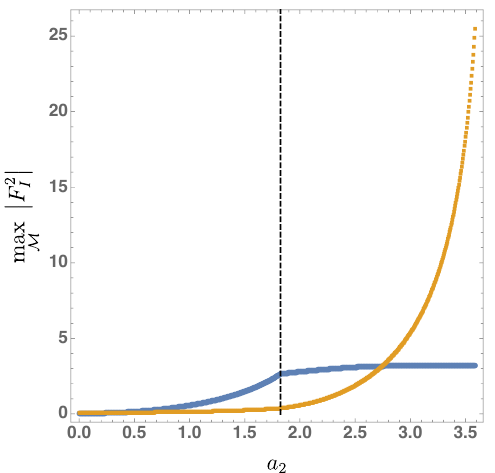
p 3 and q 2 = 4. The blue disks correspond j . The vertical dashed black line marks the onset of (cid:8) 1 . 2